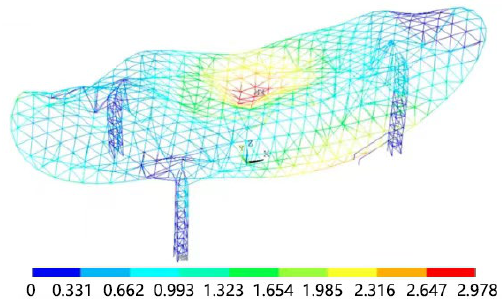
Buildings 2022 , 12 , 1674 Figure 9. Elastic instability of the roof structure. Figure 9. Elastic instability of the roof structure.